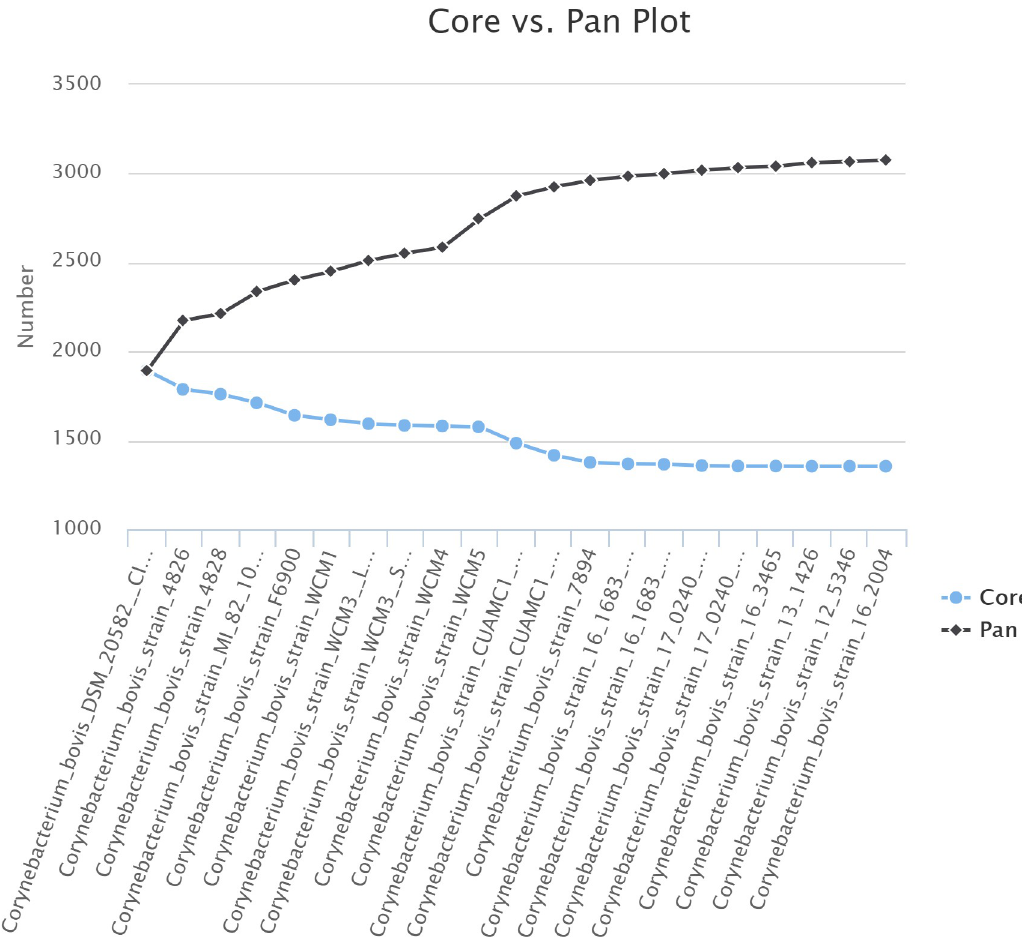
Fig 7. Plot of the pan-genome vs. core-genome for each of the 21 C . bovis isolates. The number of core genes is reflected in blue and the pan-genome in black for each of the isolates.